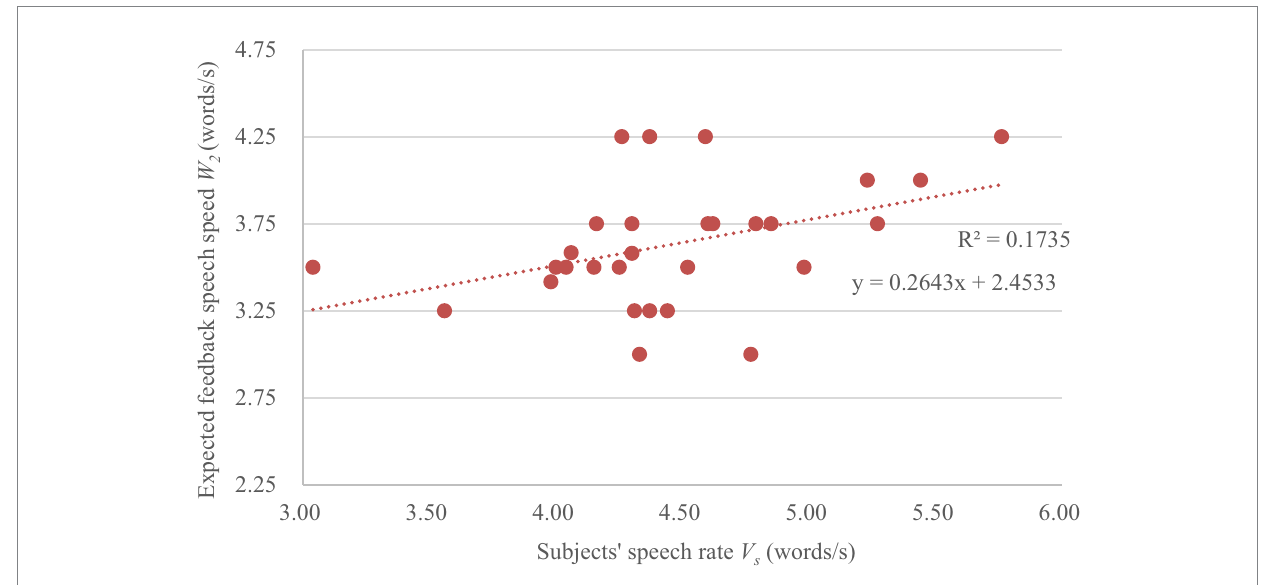
FIGURE 6 The variation of the expected feedback speech rate W 2 with the subjects’ speech rate V s